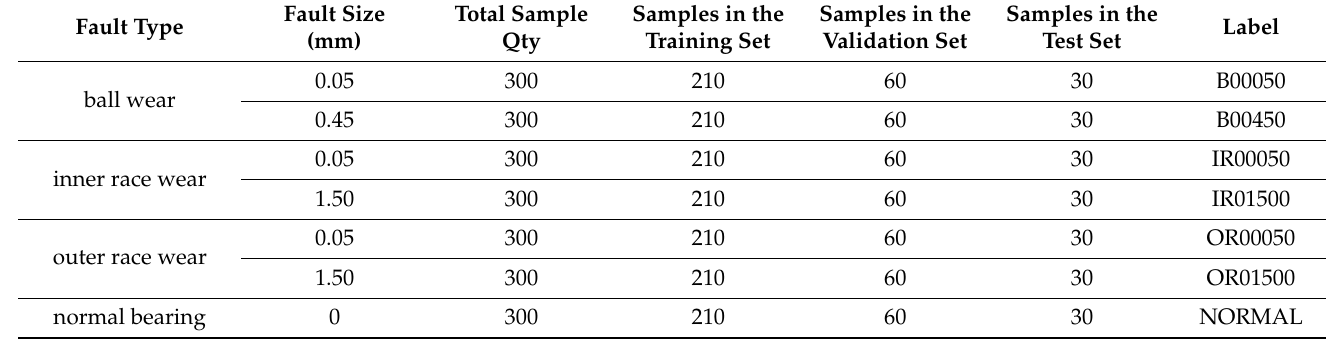
Table 4. Introduction to image data sets.